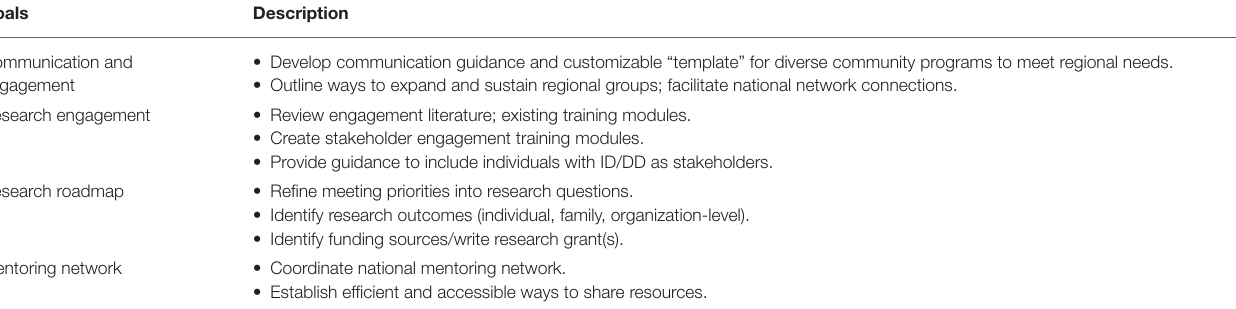
TABLE 6 | Workgroup goals.